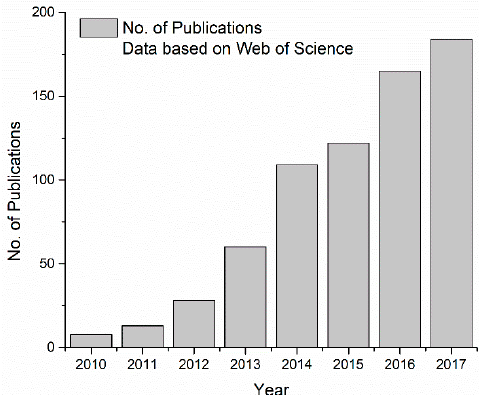
Figure 1. Number of publications in Web of Science with topic on “Silicon + Anode + Graphene” from 2010 to 2017.